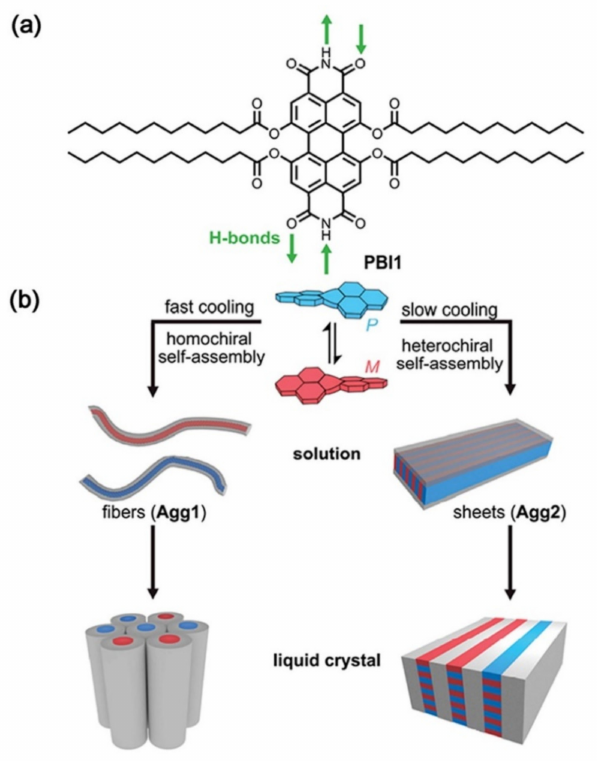
Figure 8. ( a ) Chemical structure of PBI1. ( b ) Schematic illustration of homochiral fibers (Agg1) and heterochiral sheets (Agg2) self-assembled by cooling PBI1 solution (90 ◦ C) with 10 and 0.6 K/minute, respectively, and their subsequent organization into columnar or lamellar LCs. Reprinted with permission from reference [134]. Copyright (2020) John Wiley and